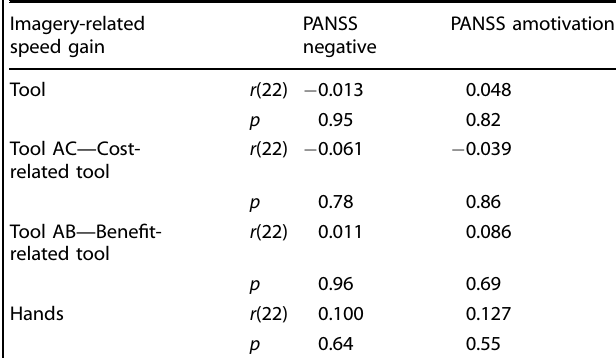
Fig. 2 Imagery-related speed gain as a function conditions in both groups. Stars indicate signi fi cant post-hoc differences — Student ’ s t tests — with a level of signi fi cance of p < 0.05, corrected using the Bonferroni procedure. A positive score indicated that the participants took less time to imagine the actions compared to the execution of the actions (hands are represented in white, tool in black, tool/distance AB in dark gray, tool/distance AC in light gray, and error bars correspond to standard errors.